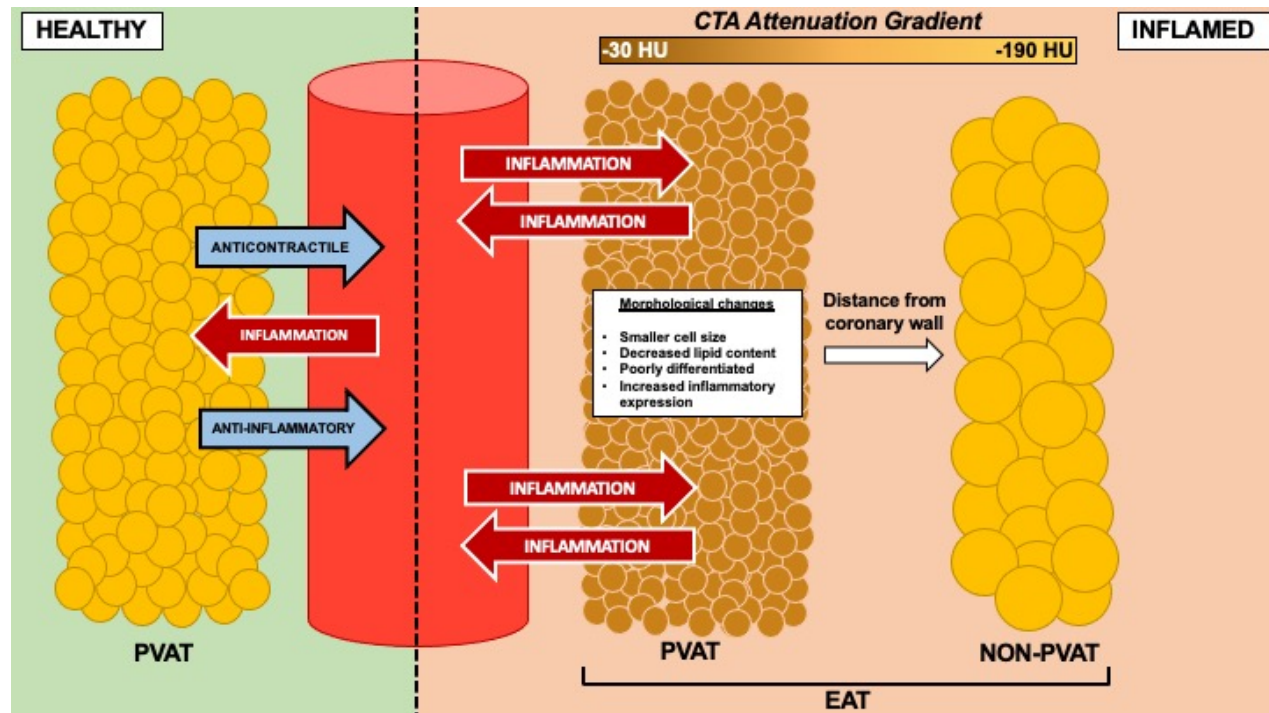
Figure 1. Schematic representation of bidirectional signalling between the vasculature and adipose tissue, particularly perivascular (or pericoronary) fractions of epicardial adipose tissue (EAT). Under ‘healthy’ conditions, perivascular adipose tissue (PVAT) typically exhibits anticontractile and anti-inflammatory properties in response to markers of oxidative stress and inflammation from the vasculature. Under ‘inflamed’ conditions, PVAT undergoes unique phenotypic changes due to vascular inflammation compared to non-perivascular adipose tissue located further from the vessel wall. These changes are detectable as increased attenuation on coronary computed tomography angiography (CTA).